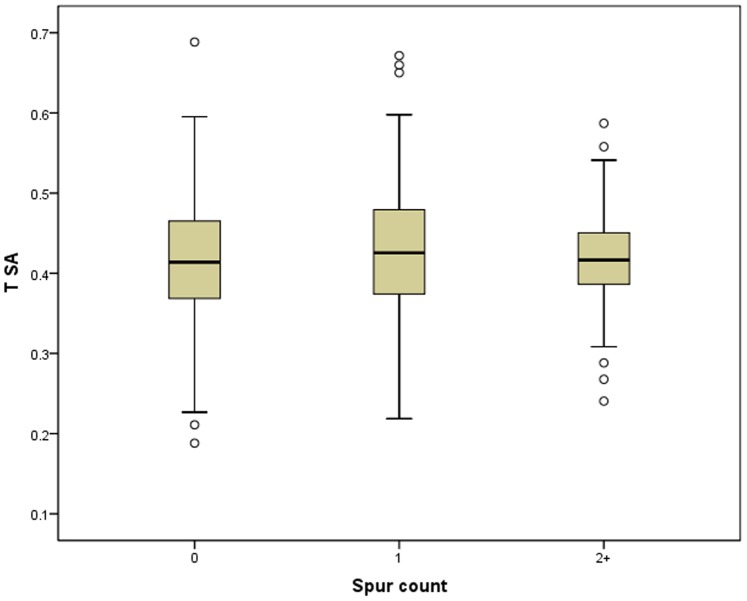
Box plots of TSA vs. spur count.